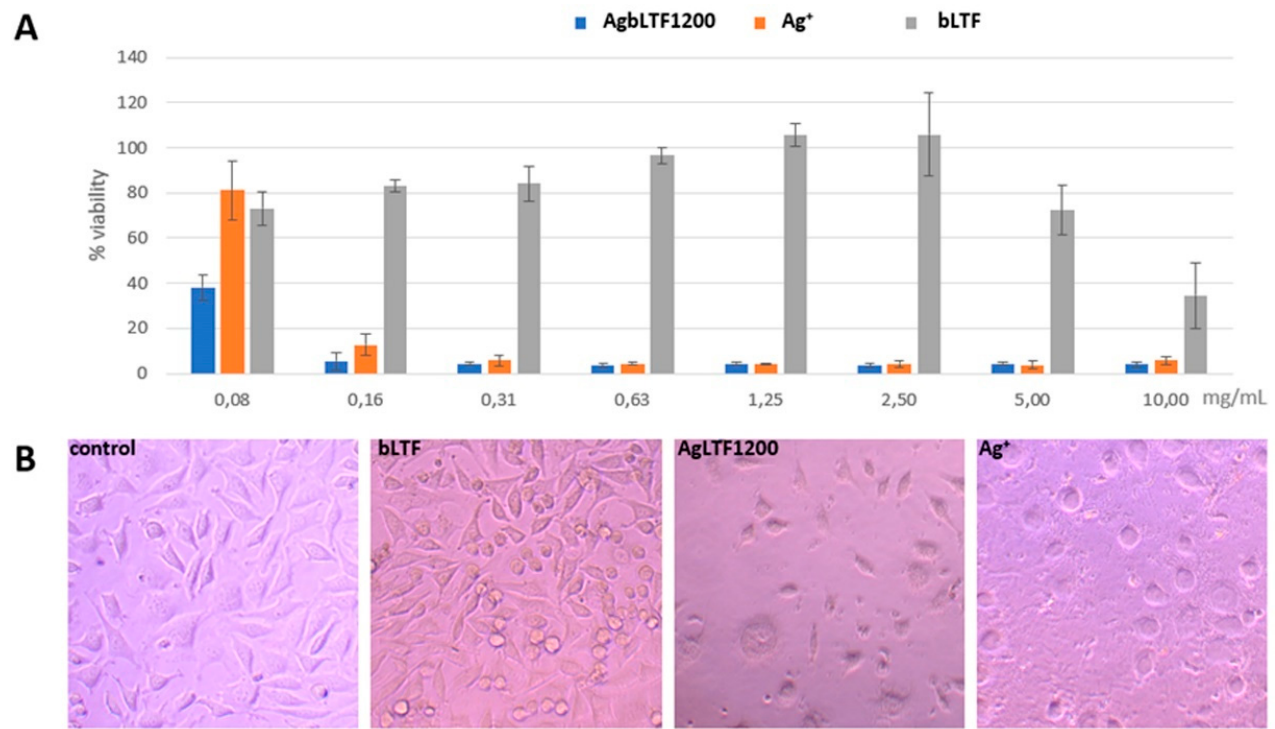
Figure 11. ( A ) Represents cell viability measured by MTT assay. Histograms show the percentage, with respect to control cells (100%), of viable cells after exposure to AgLTF1200, Ag + and bLTF. Data show the mean ± SE (n = 5); ( B ) Morphology of L929 control cells and after exposure to bLTF, AgLTF1200, and Ag + .